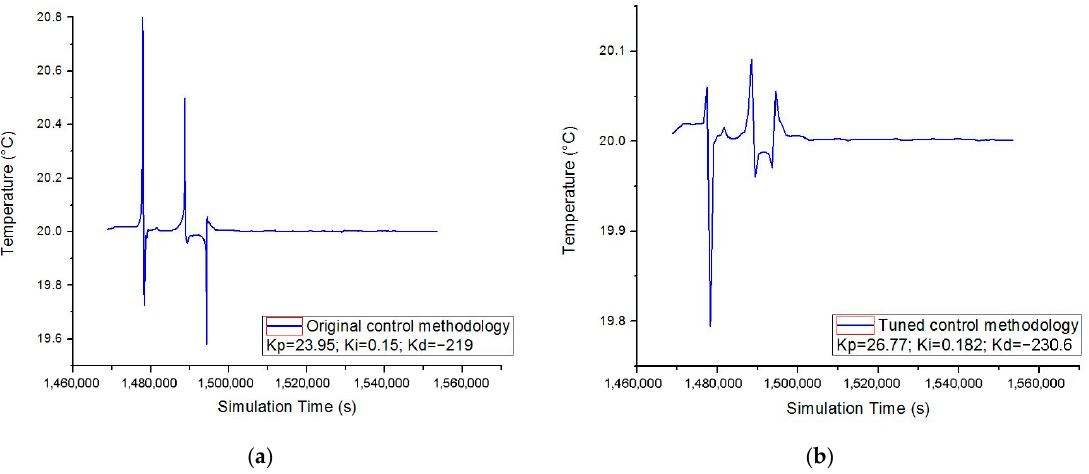
Figure 20. ( a ) Temperature inside the enclosure for the original control methodology and ( b ) temperature inside the enclosure for the tuned control methodology.